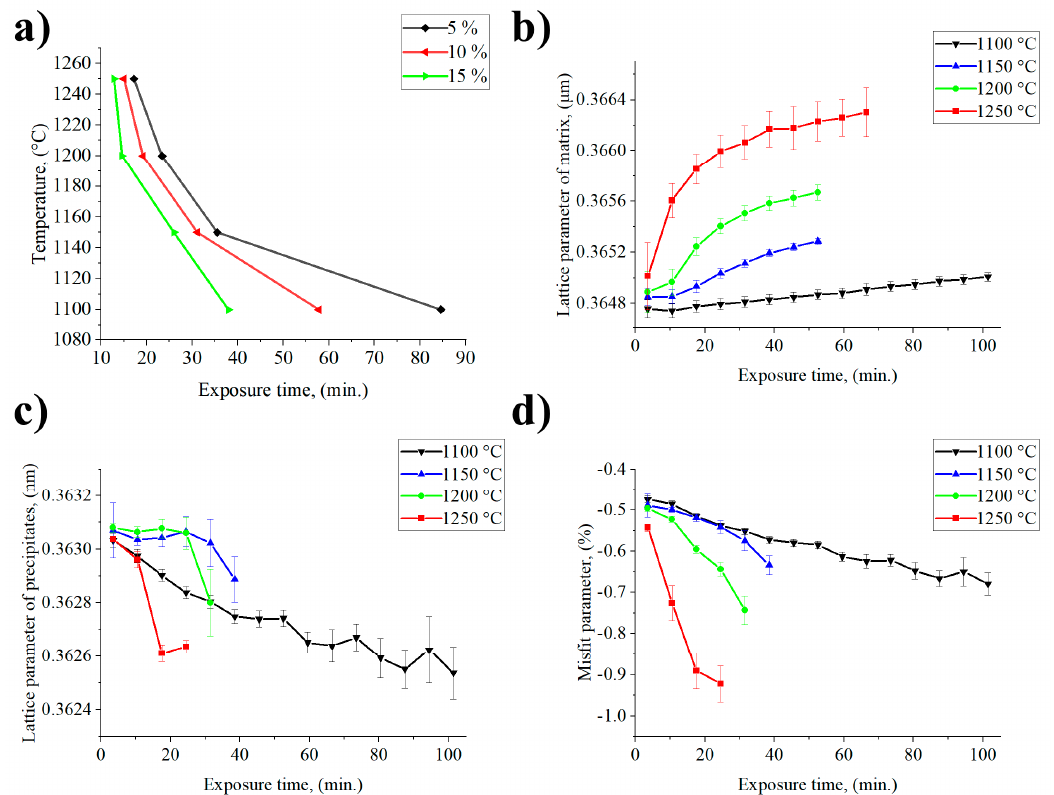
Figure 9. Influence of exposure time and temperature on: ( a ) time-temperature-transformation diagram; ( b ) lattice parameter of γ phase; ( c ) lattice parameter of γ (cid:48) phase; ( d ) misfit parameter ( δ ). Table 1. Change of equilibrium solubility of selected γ (cid:48) formers in Ni matrix with increasing temperature calculated by Thermo-Calc software.